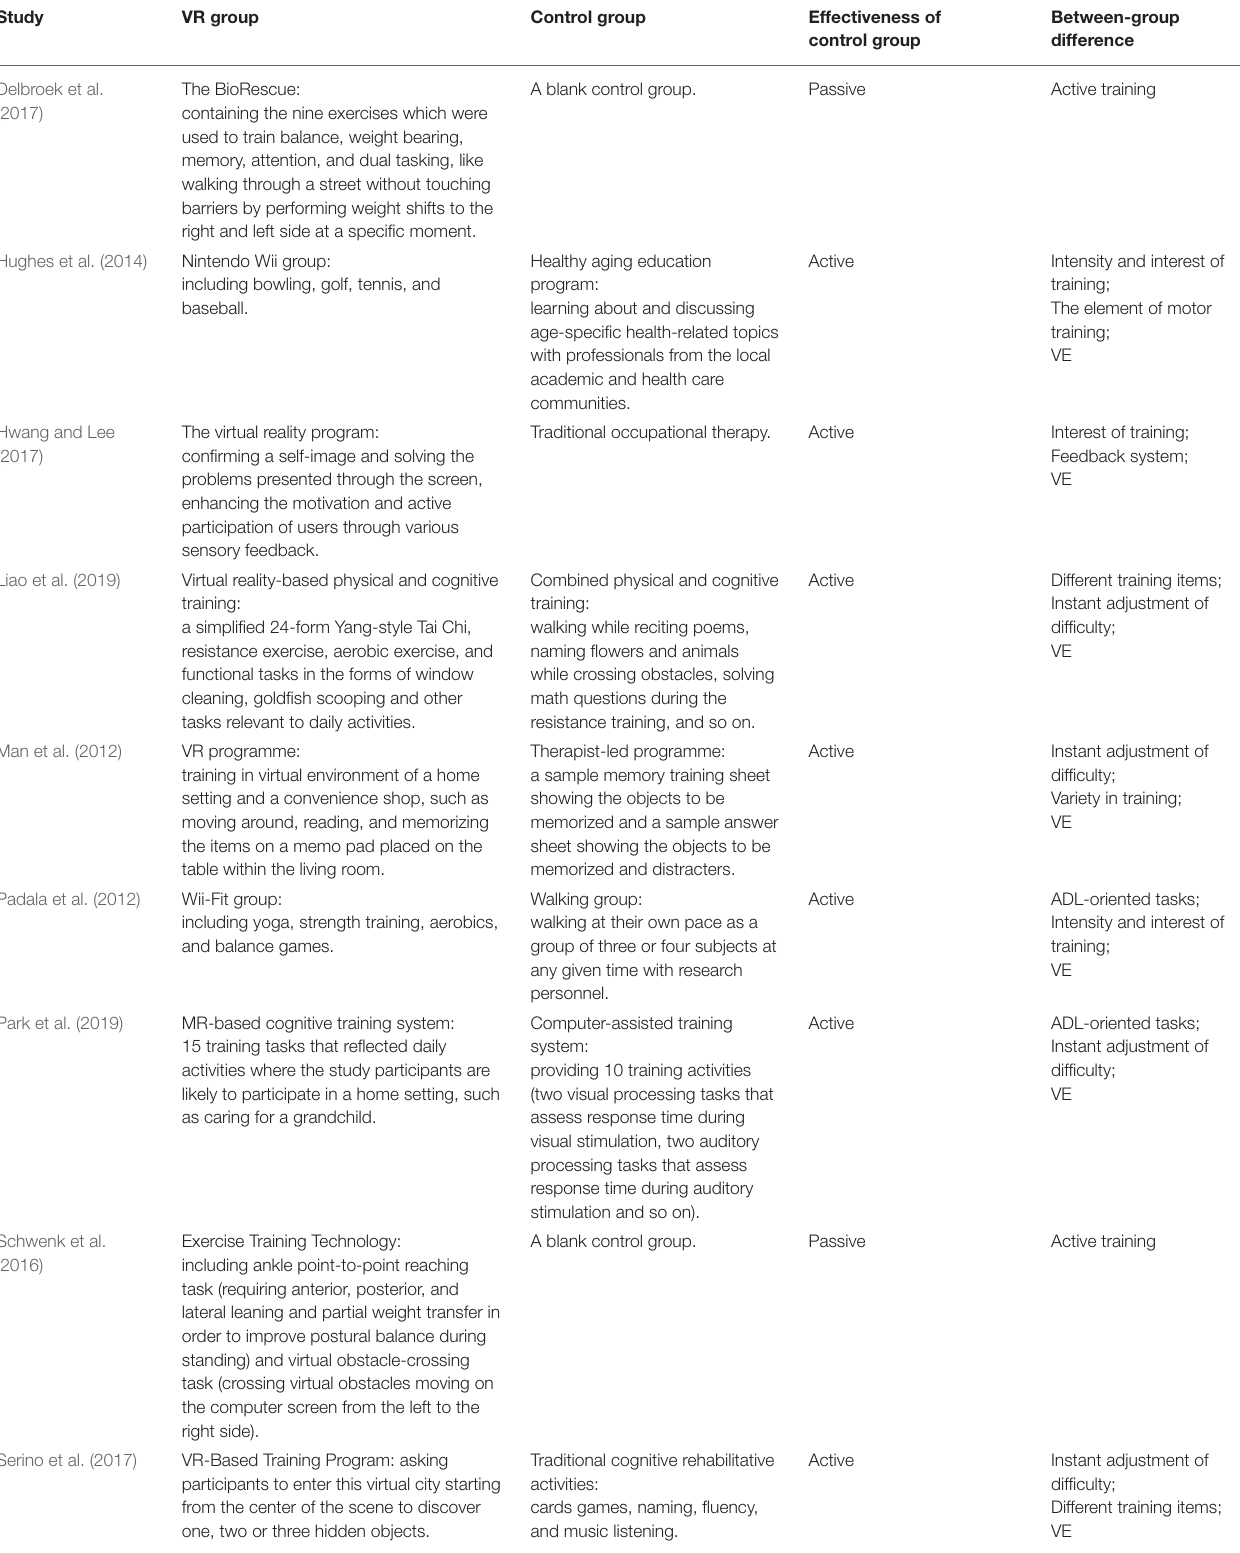
TABLE 2 | Comparison of